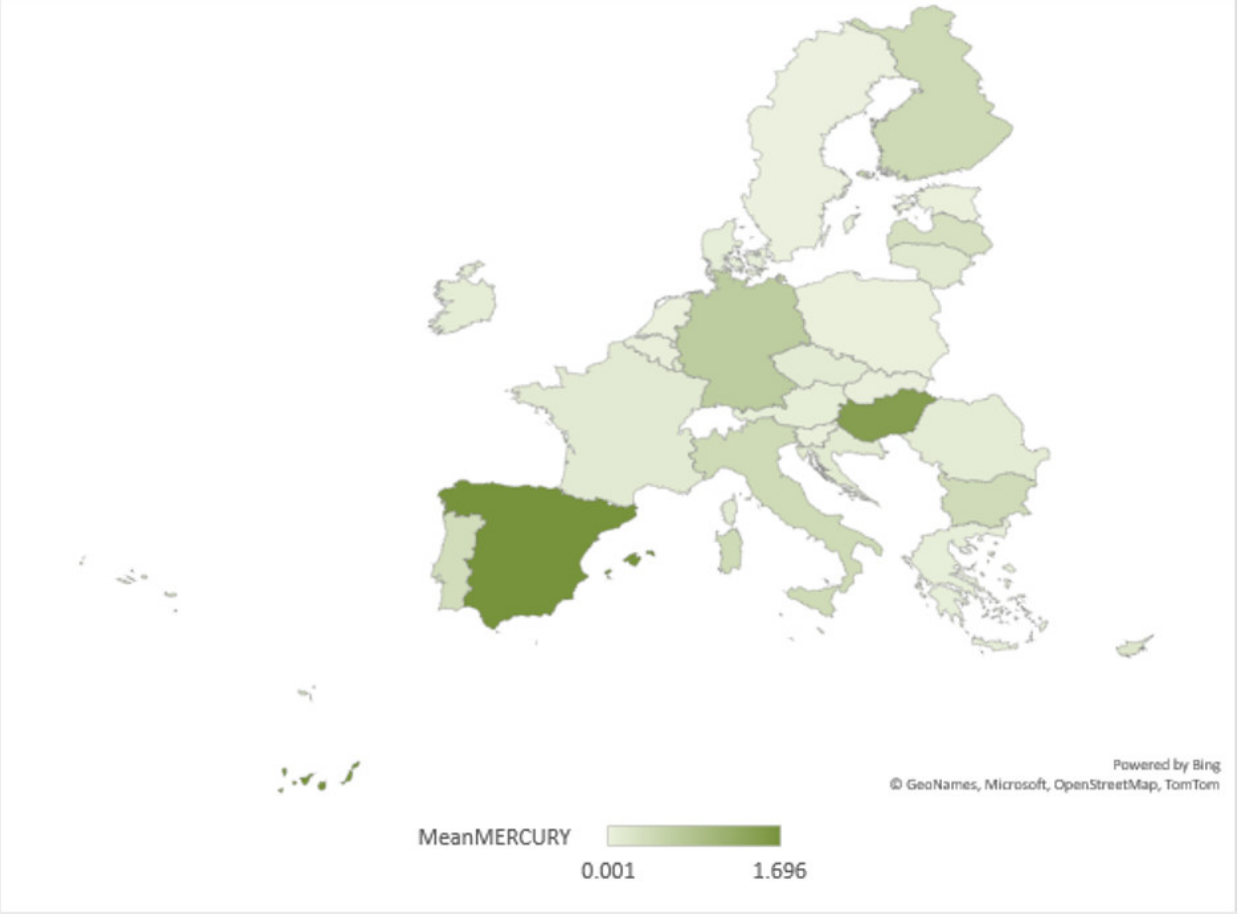
Figure 9. Disparities in policies to combat mercury water pollution in the EU.